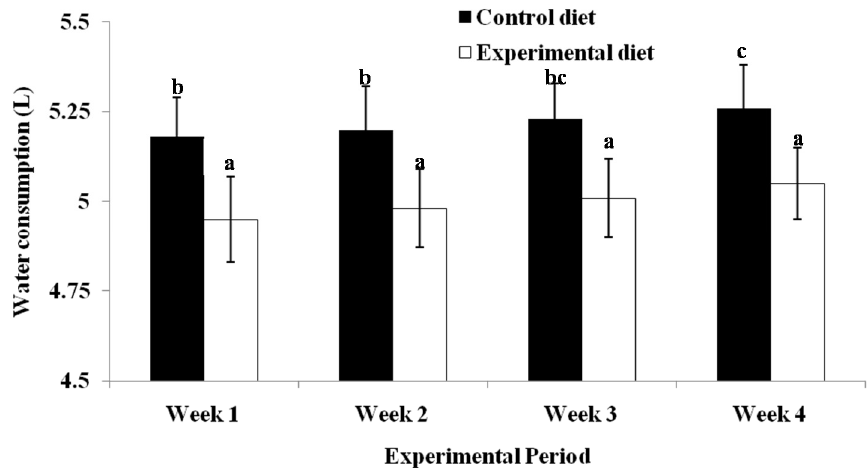
Figure 2. Water consumption during the experimental period. All data are the mean ± SD of three replicates. Mean followed by different letters in the same column differ significantly ( p < 0.05) between the control and experimental